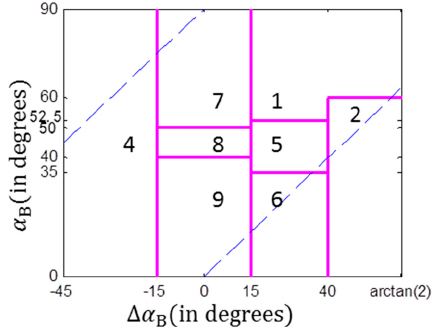
Figure 1. The Δ(cid:2009) (cid:2886) /(cid:2009) (cid:2886) scattering mechanism classification diagram, where the blue dash line indicates tilted boundaries. Zone 1: high entropy Multiple scattering; Zone 2: high entropy vegetation scattering; Zone 4: high entropy double-bounce scattering; Zone 5: medium entropy vegetation scattering; Zone 6: medium entropy dominant surface scattering; Zone 7: low entropy double-bounce scattering; Zone 8: low entropy dipole scattering; Zone 9: low entropy surface